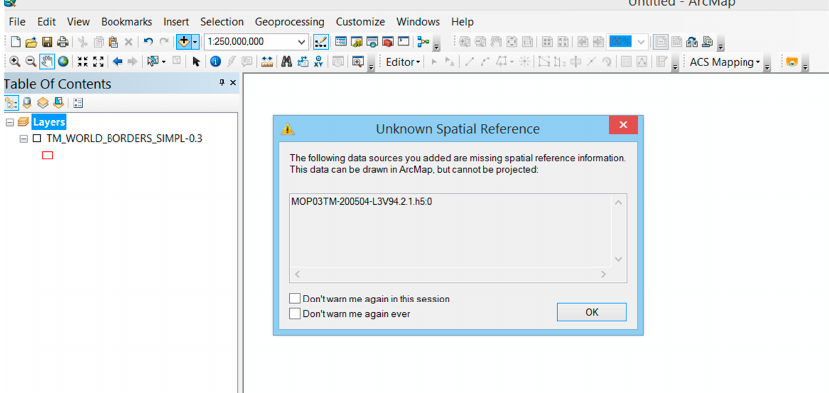
Figure 2. A pop-up message showing ArcGIS cannot interpret the geo-reference information of data.